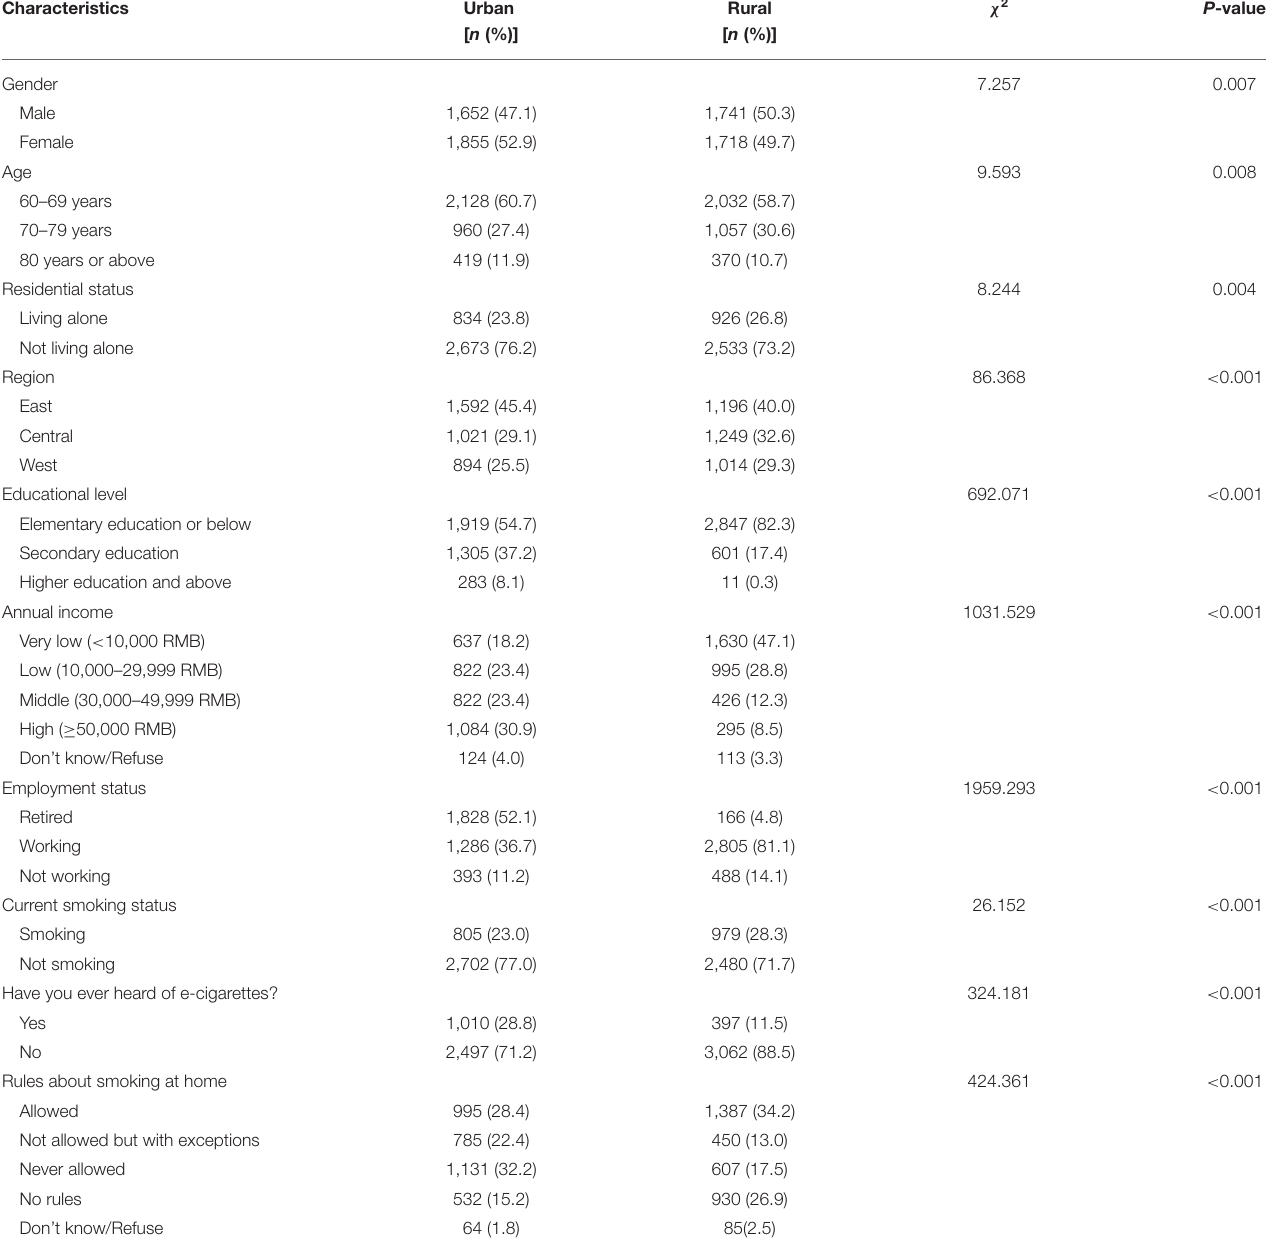
TABLE 1 | Comparison of demographic characteristics and smoking status between the urban and rural elderly in China.